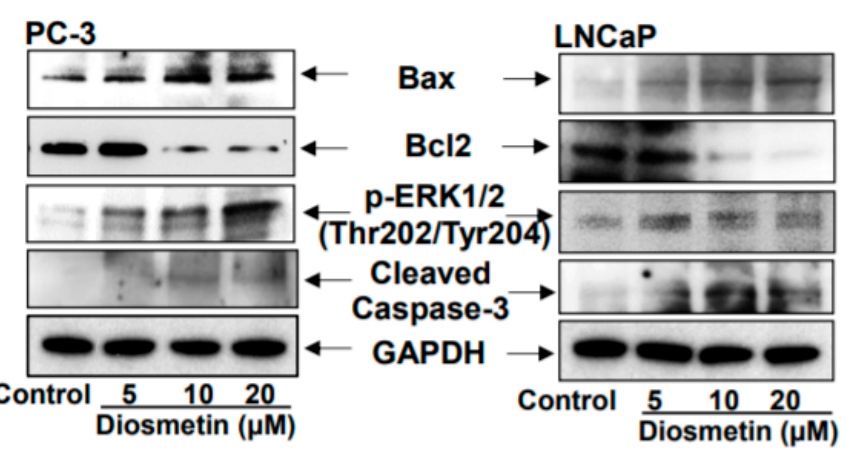
Figure 6. Diosmetin dose response effect on BCl2, Bax, Cleaved caspase-3 and ERK1/2 protein expression. Prostate cancer, LNCaP and PC-3, cells were treated with diosmetin (5, 10, 20 µ M) for 24 h. Total lysates were made to observe the altered expressions of BCl2, Bax, Cleaved caspase-3 and ERK1/2. For protein, control blots were stripped and reprobed with GAPDH.